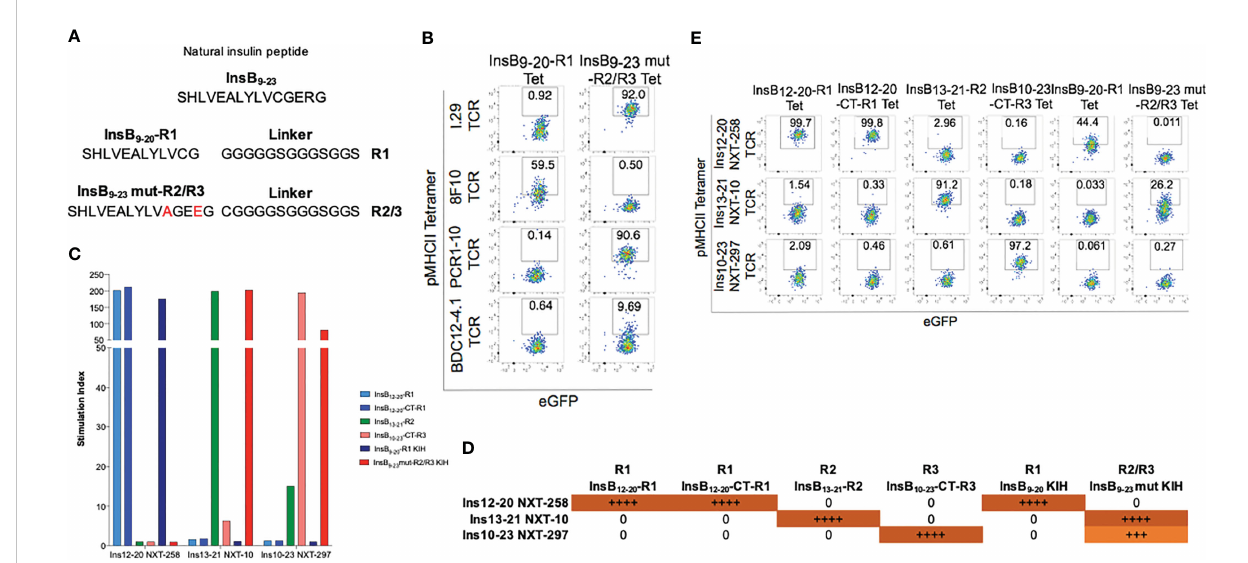
FIGURE 6 Reactivity patterns of two additional Insulin B 9-23 /IA g7 pMHCII designs to reporter Jurkat cell lines expressing the TCRs studied in Figure 1 or TCRs cloned from tetramer+ cells arising in pMHCII-NP-treated NOD mice. (A) Peptide-linker sequences of two novel pMHCII designs, displaying Insulin B 9-23 bound to IA g7 on the R1 or R2/R3 registers. (B) Binding of the two pMHCII tetramers from A to the Jurkat cell lines used in Figure 1B, (C) NFAT- driven luciferase activity in Jurkat cell lines expressing TCR ab pairs cloned from pMHCII-NP-induced tetramer+ cells, in response to the six